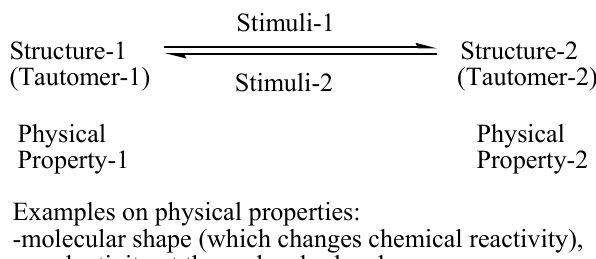
Figure 1. A simplified illustration for the concept of “molecular switching”.